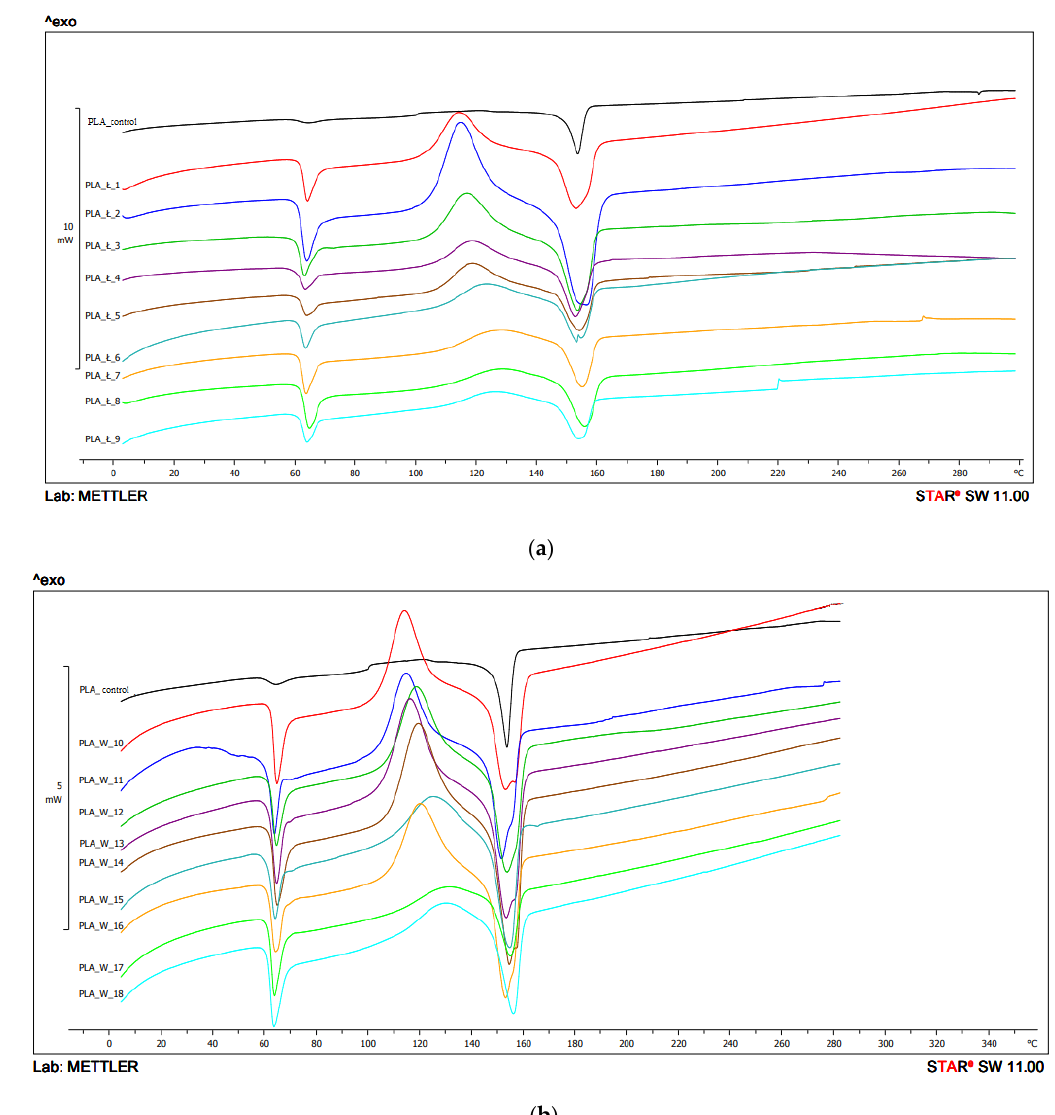
Figure 5. DSC thermograms heating analysis 1: ( a ) configuration 1; ( b ) configuration 2.